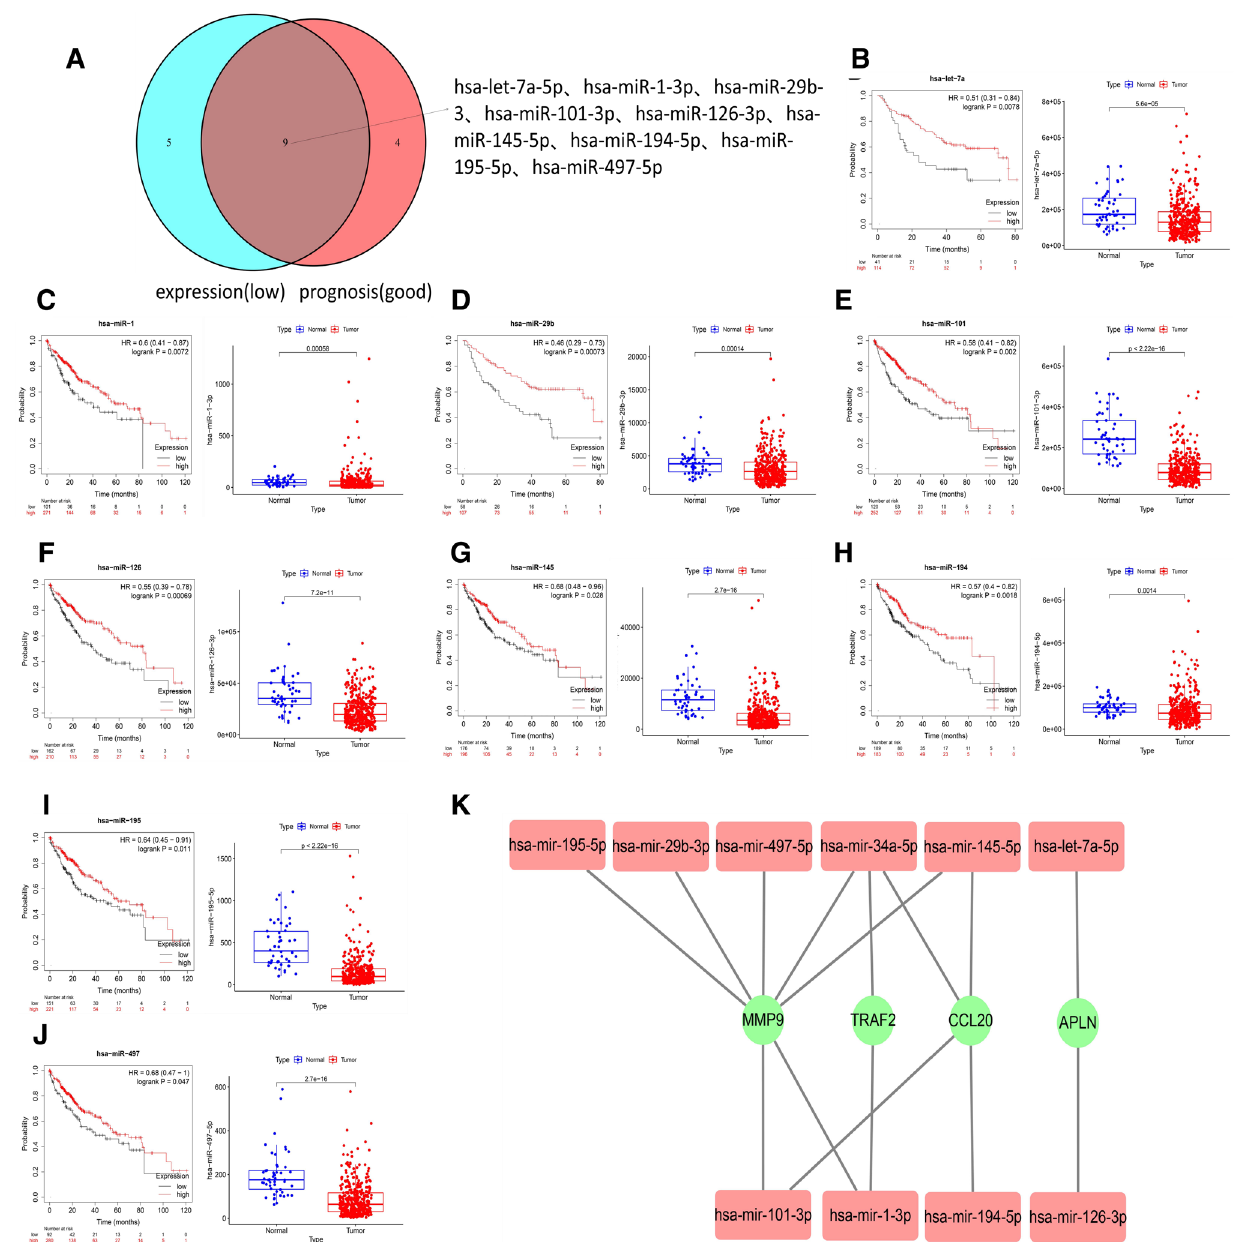
Fig. 3 miRNAs with significant differential expression and prognostic implications in HCC. a Nine miRNAs that were expressed at low levels in HCC and predict good prognosis in HCC patients were integrated by Venn diagram. The differential expression and prognostic implica- tions of these nine miRNAs hsa-mir-29b-3p ( b ), hsa-mir-145-5p ( c ), hsa-mir-195-5p ( d ), hsa-mir-497-5p ( e ), hsa-mir-1-3p ( f ), hsa-mir-101-3p ( g ), hsa-let-7a-5p ( h ), hsa-mir-126-3p ( i ), and hsa-mir-194-5p ( j ) were analyzed in HCC. k The interaction between mRNA and